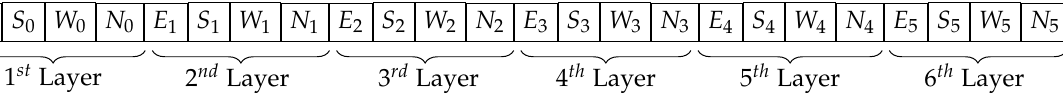
Figure 3. Action array output by the reinforcement learning model. Each successive four positions represent a traffic layer. The highest integer value indicates the direction (east, south, west, or north) to be allowed in the respective